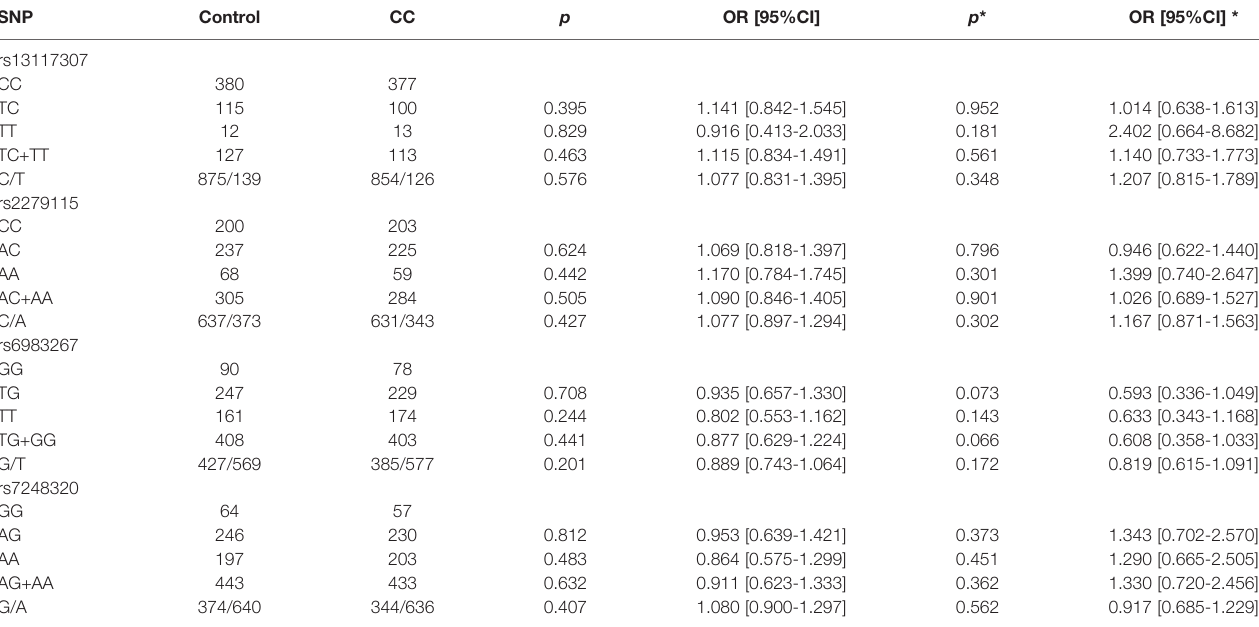
TABLE 3 | The frequencies distribution of genotypes and alleles of four SNPs in CC patients and healthy controls.